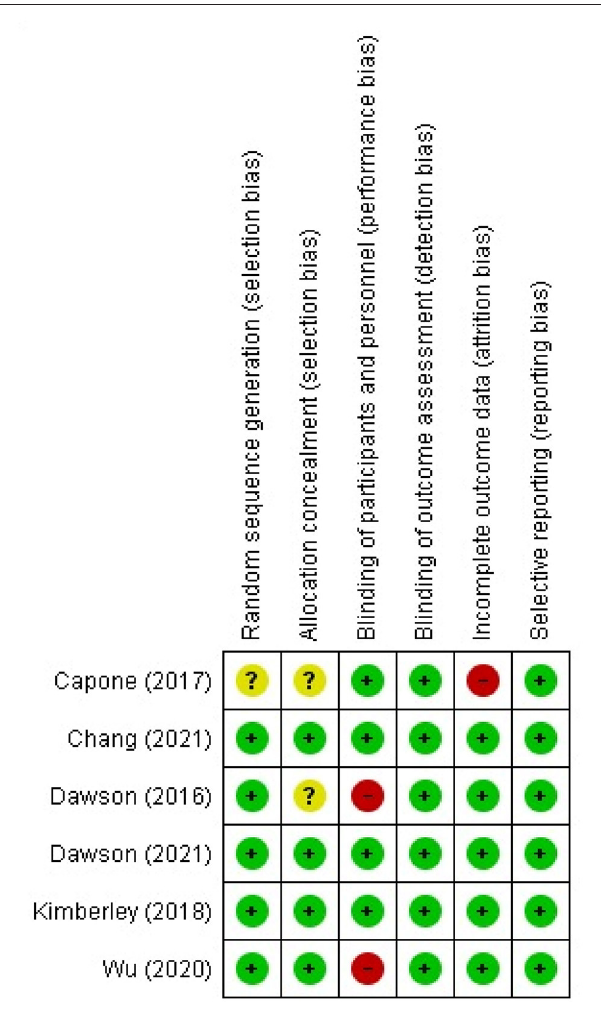
FIGURE 7 | Risk of bias of the clinical trials included in the